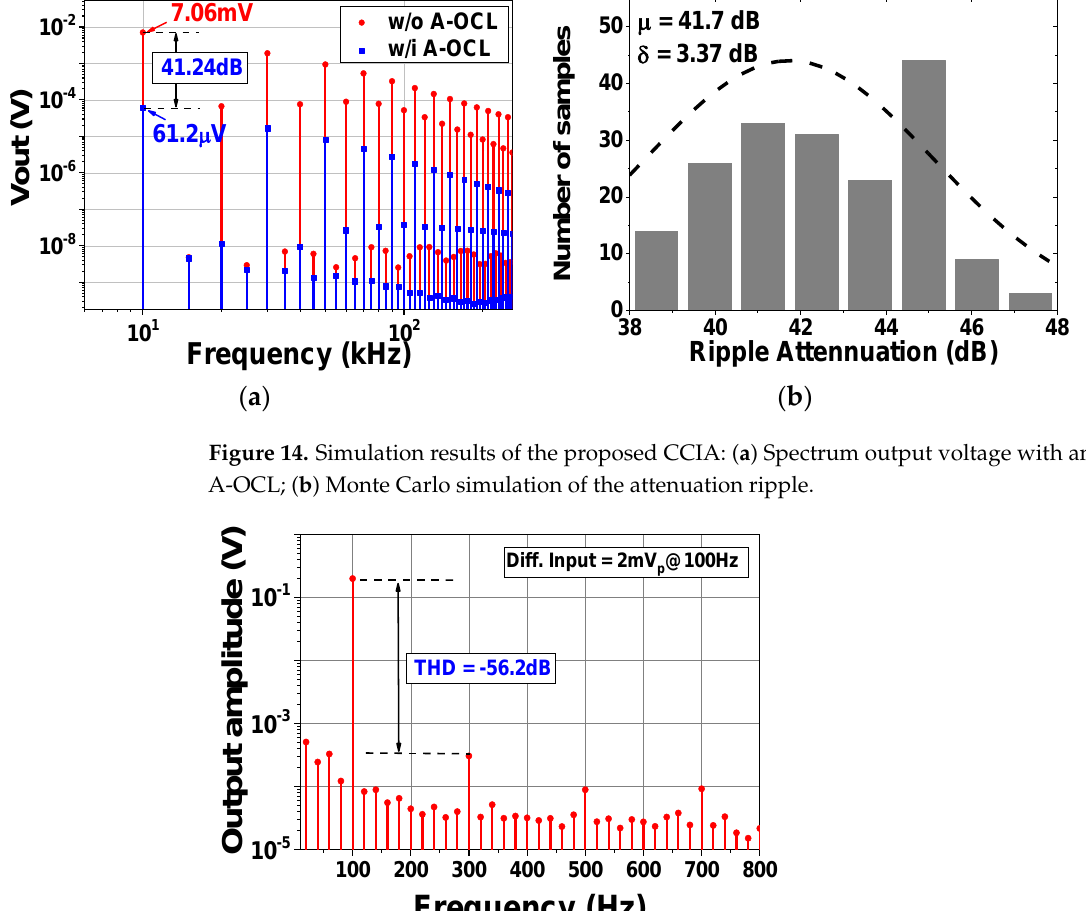
Figure 13. Monte Carlo simulation results of the proposed CCIA: ( a ) Common mode rejection ratio CMRR; ( b ) power supply rejection ratio PSRR.